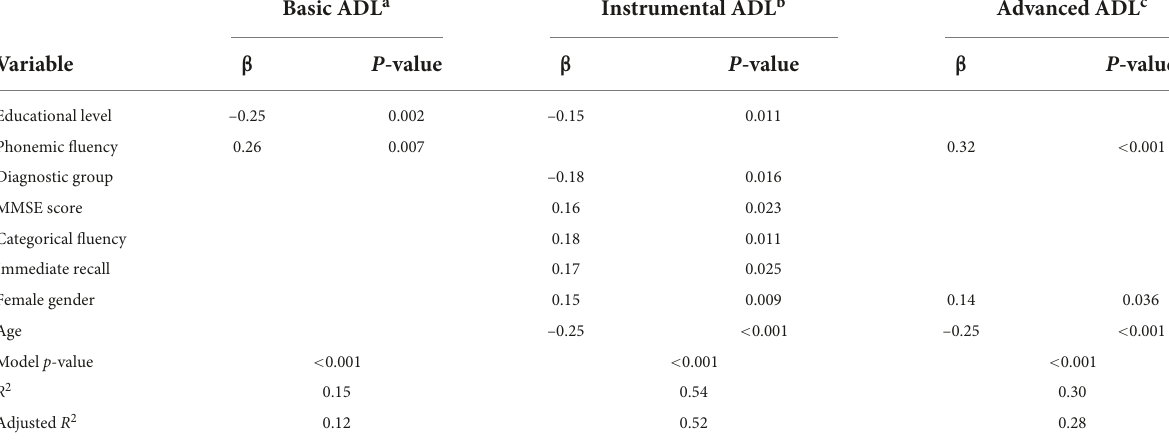
TABLE 4 Regression models with predictors for ADL informant-report scales